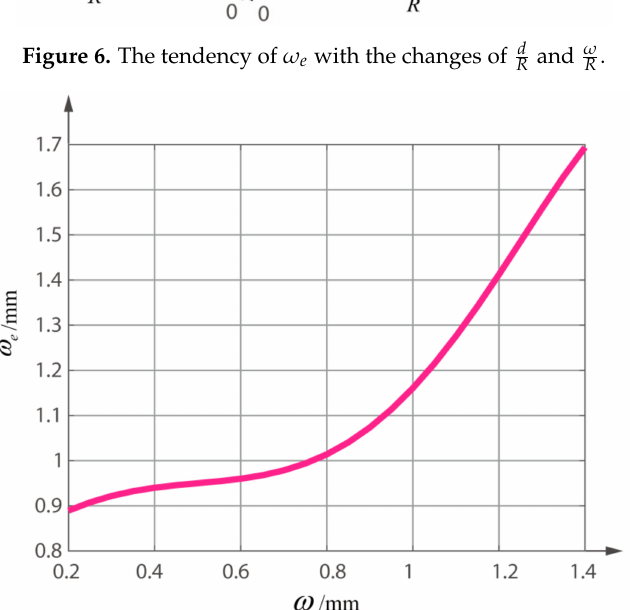
Figure 6. The tendency of ω e with the changes of d